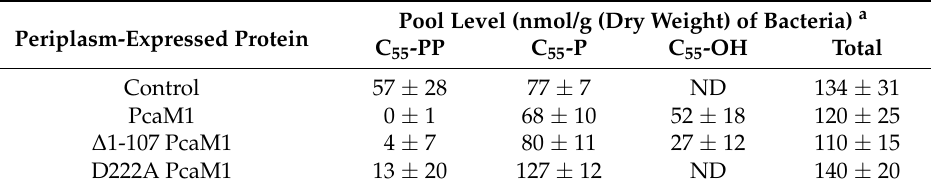
Table 1. Pool levels of C 55 ‐ isoprenoids in E. coli FB8 cells following periplasmic expression of PcaM1 and its variants.